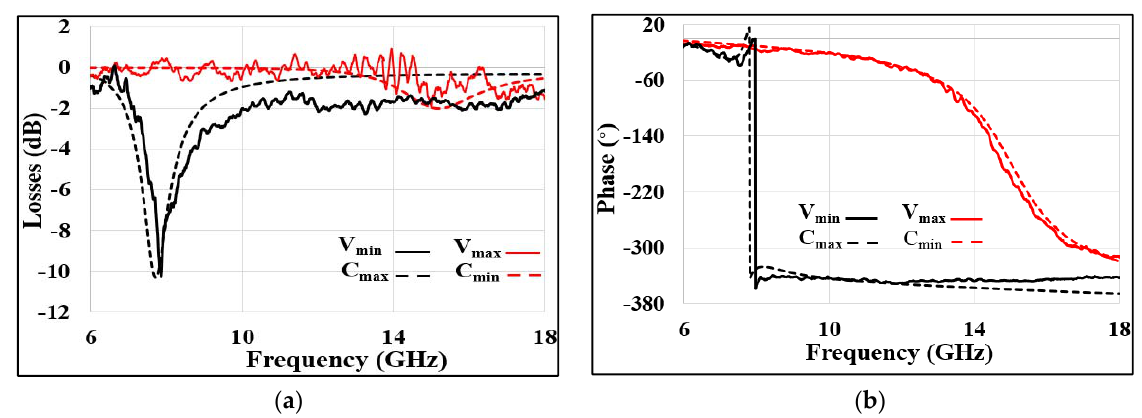
Figure 10. Unit cell reflection measurement and simulation results in continuous lines and dashed lines, respectively: ( a ) reflection magnitude and ( b ) reflection phase.